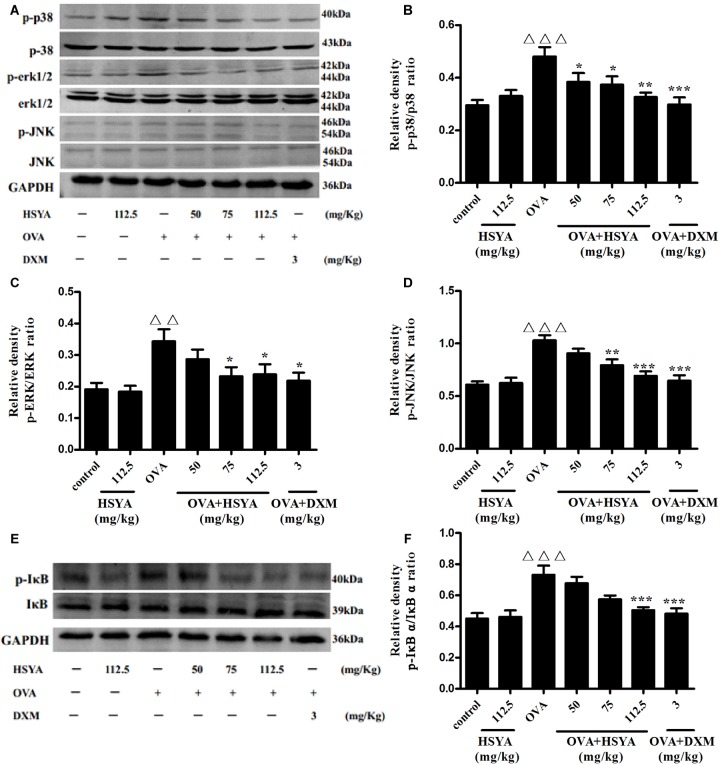
Effects of HSYA on phosphorylated p38 MAPK, ERK MAPK, JNK MAPK, and IκBα in lung tissues by western blot. Protein expression levels were measured by western blotting (A,E). Densitometric analyses of p38 MAPK (B), ERK MAPK (C), JNK MAPK (D) and IκBα (F). Data presented as mean ± SD. ΔΔp < 0.01, ΔΔΔp < 0.001 versus normal control group, ∗p < 0.05, ∗∗p < 0.01, ∗∗∗p < 0.001 versus OVA group.